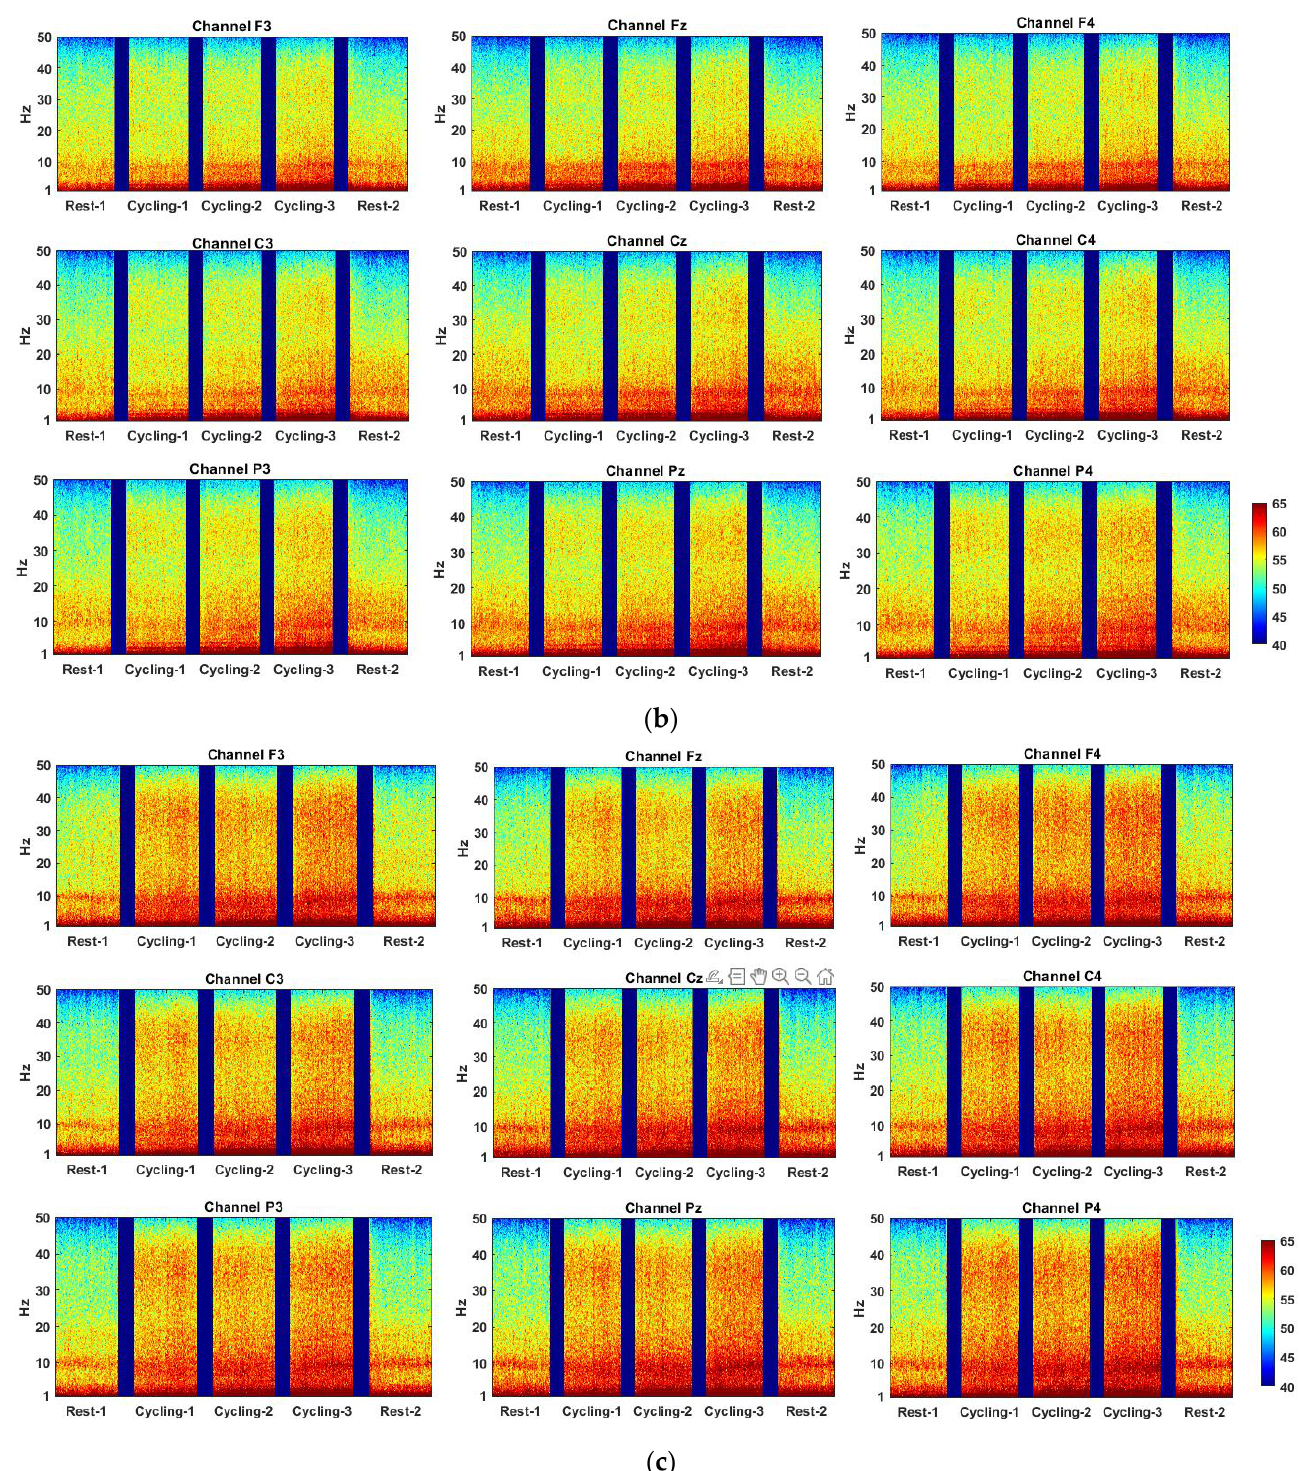
Figure 2 . ( a ) EEG power spectral density in the 0.5 – 50 Hz interval of 9 channels in Class 1 (Note: Y-axis is shown in the 10 log 10 scale); ( b ) EEG power spectral density in the 0.5 – 50 Hz interval of 9 channels in Class 2; ( c ) EEG power spectral density in the 0.5 – 50 Hz interval of 9 channels in Class 3 .